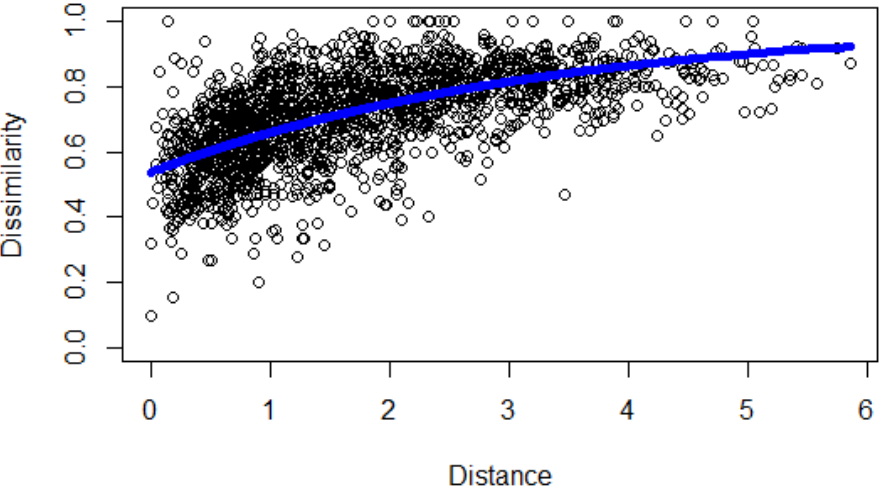
Figure 4. Sørensen dissimilarity index plotted against distance for all pairwise comparisons between sampling stations. The blue line represents the exponential function describing the increase in dissimilarity (a..intercept = 0.5355325; b..slope = 0.3067745).